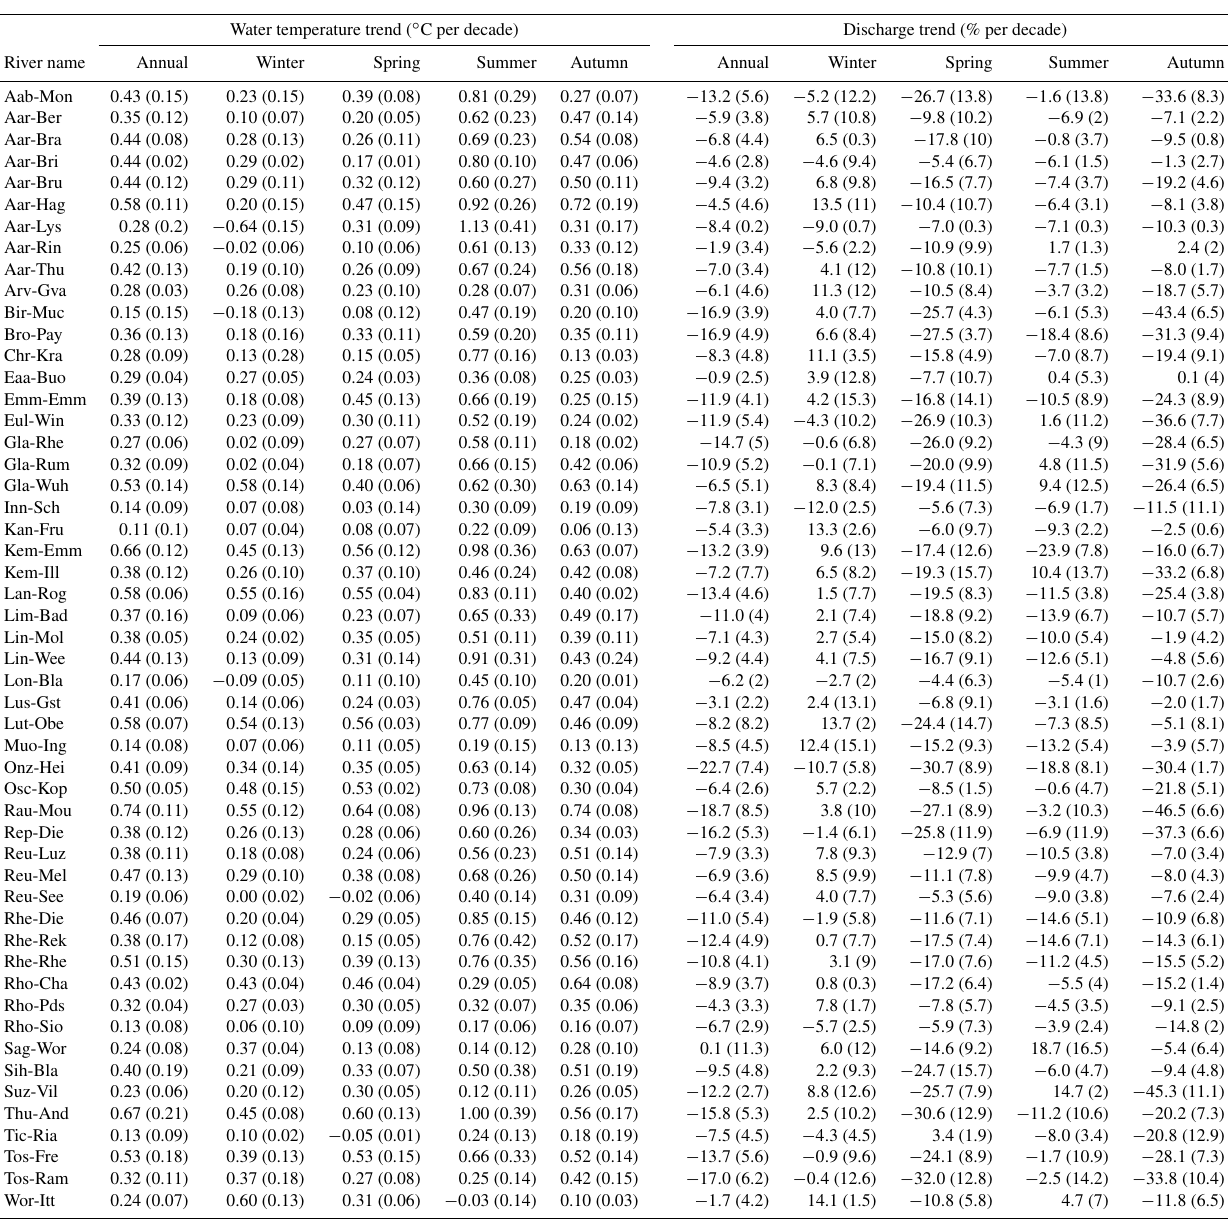
Table A1. Water temperature (left section) and discharge (right section) annual and seasonal trends for all catchments presented in Table 1 over the 1999–2018 period. The numbers in parentheses indicate the standard error of the computed trends based on linear